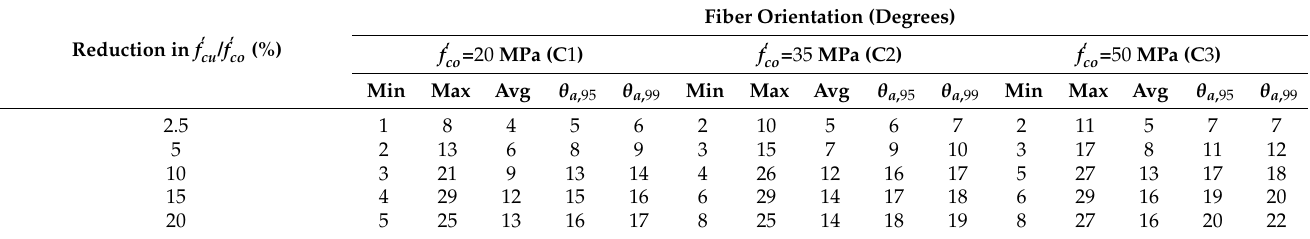
Table 9. Fiber orientations corresponding to different reductions in f (cid:48) cu / f (cid:48) co for each value of t frp . Fiber Orientation (Degrees) Reduction in 𝒇 𝒄𝒖(cid:4593) /𝒇 𝒄𝒐(cid:4593) (%)